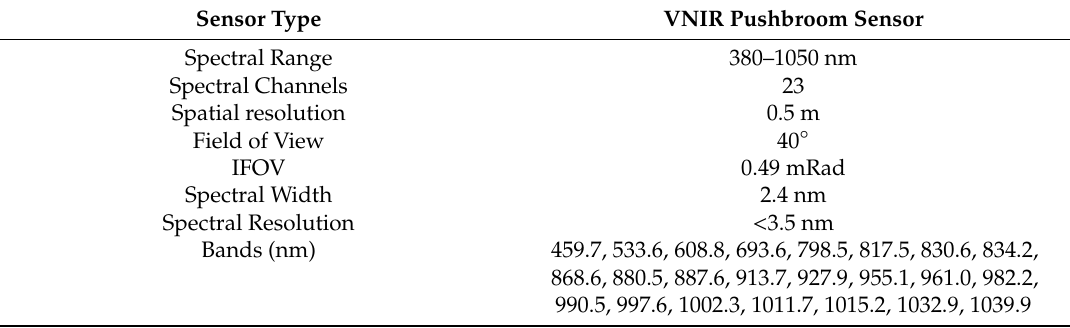
Table 2. Parameters of CASI-1500 images acquired in Liangshui.